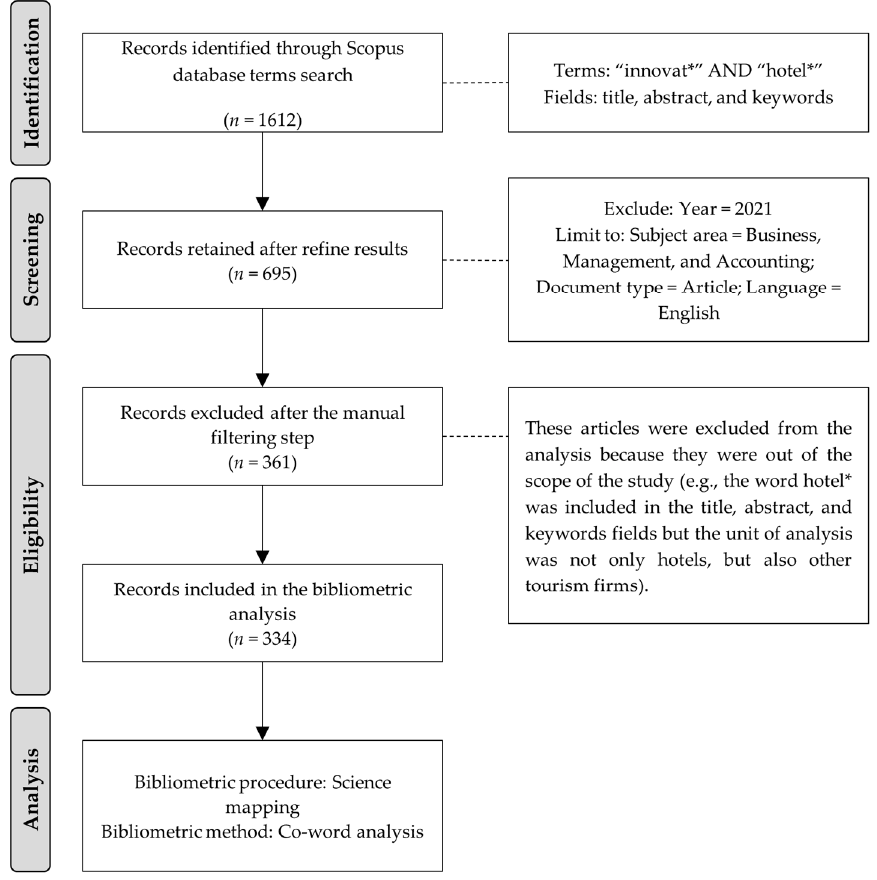
Figure 1. Process of data collection and analysis.